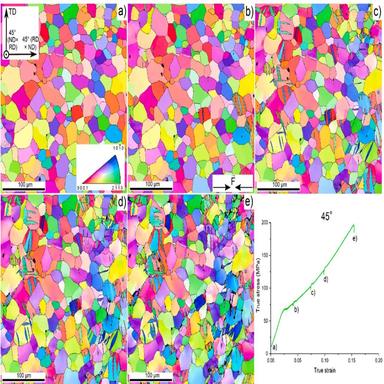
Microstructural evolution of the 45° sample during compression represented by orientation maps corresponding to several points of interest on the deformation curve. Compression was applied in the horizontal direction.